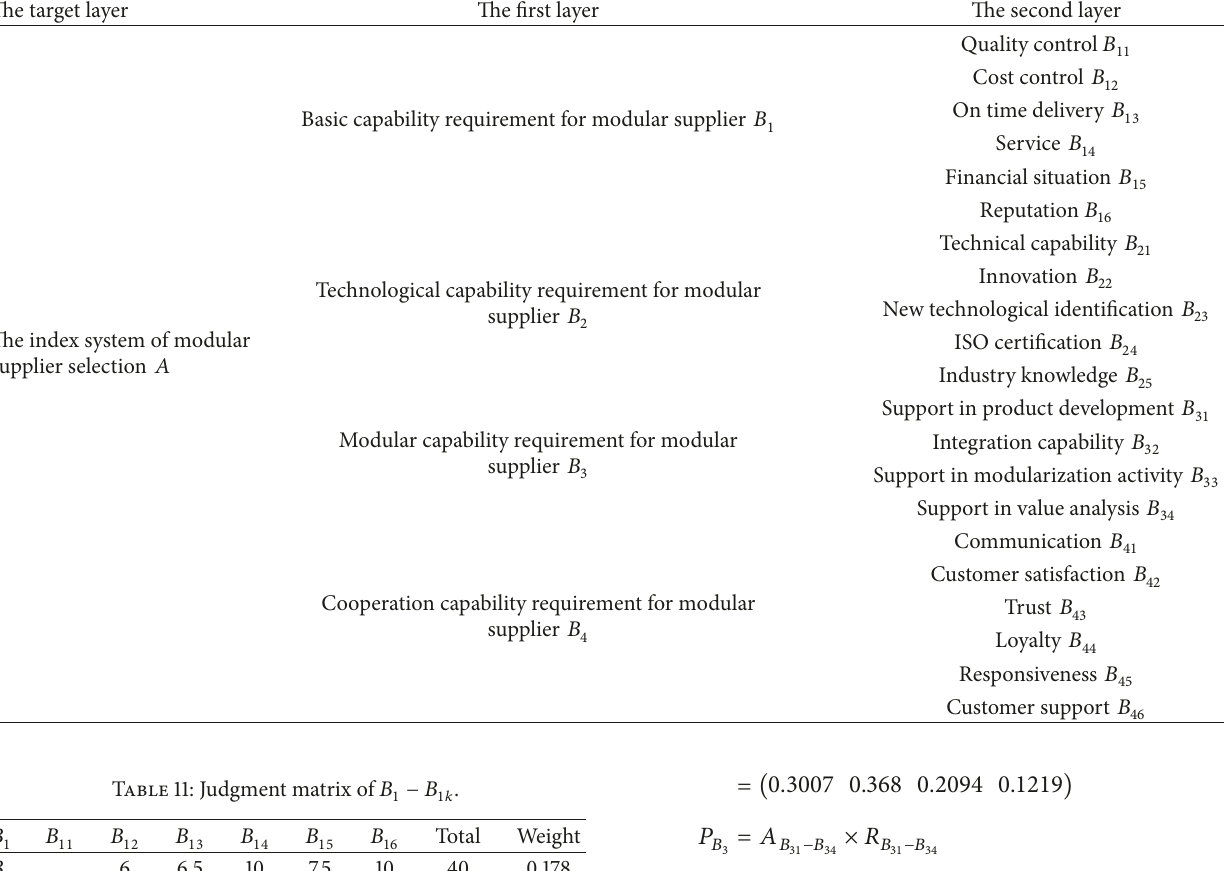
Table 10: Hierarchical structure of the index system of modular supplier selection.